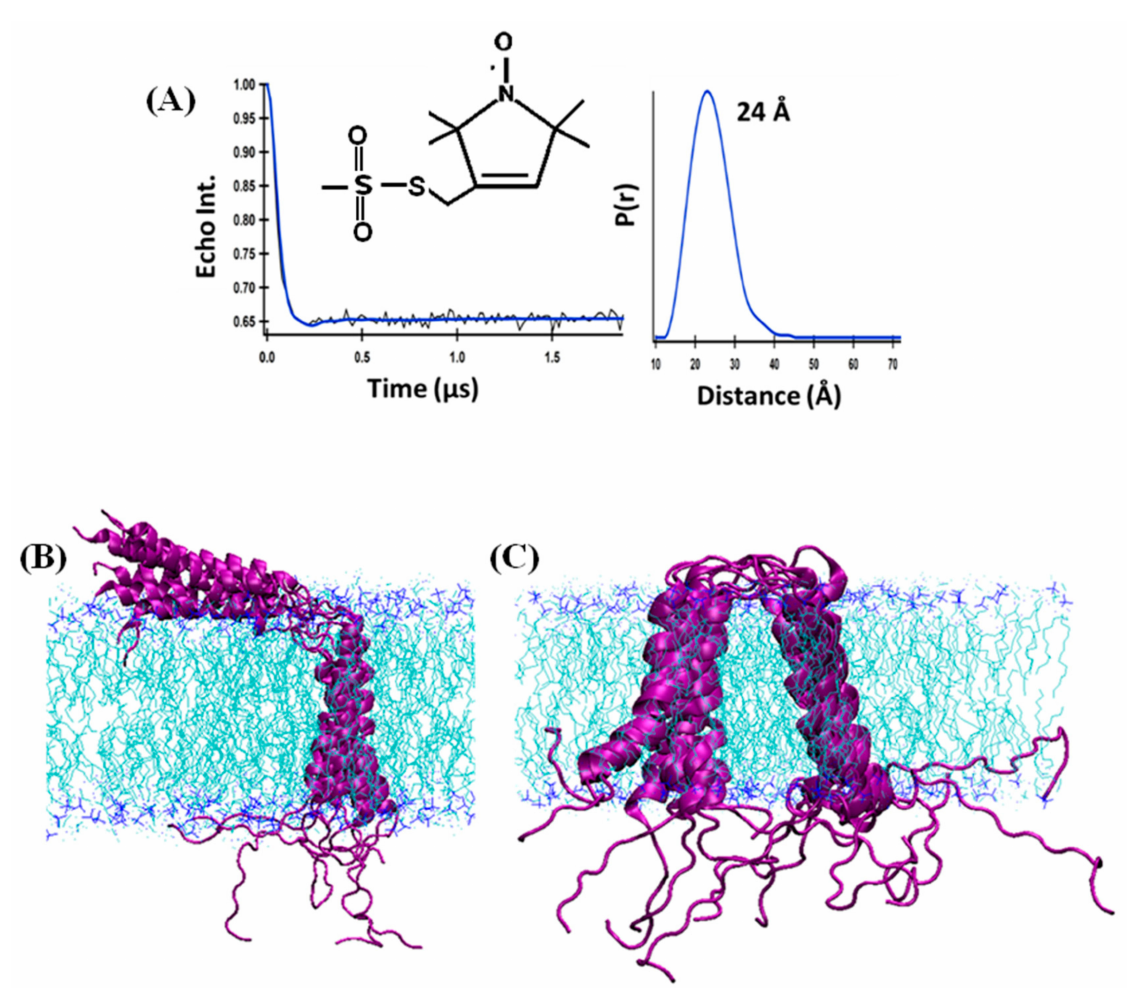
Figure 4. An illustrative example of four pulse Q-band DEER data on active form of pinholin (S 21 68) mutants (W27-A38) bearing two MTSL spin labels ( A ). The left panel shows time domain DEER data and right panel shows probability distance distribution data. The schematic representation of the MTSL spin labeling probe is shown as inset in the left panel of the figure. Overlay of the ribbon representation of the eight lowest energy structures of active form of pinholin (S 21 68) ( B ), and inactive form of pinholin (S 21 68 IRS ) ( C ) in DMPC lipid bilayers. (Adapted from [110] with